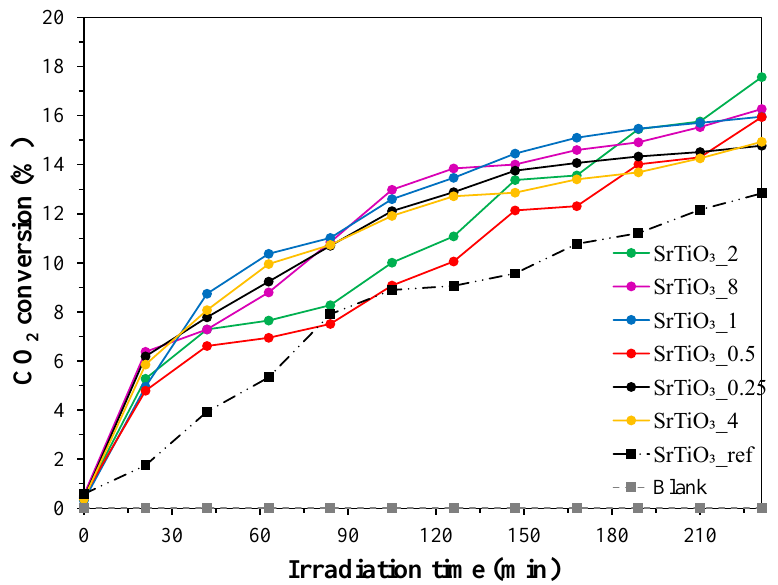
Figure 5. Photocatalytic conversion of CO 2 with SrTiO 3 photocatalysts prepared at various EG:H 2 O ratios.